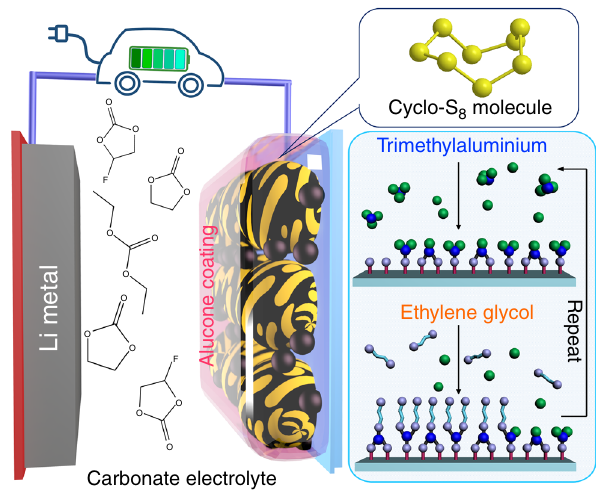
Fig. 1 Schematic of a lithium sulfur battery in carbonate-based electrolyte. Alucone coating is applied to carbon – sulfur electrodes and the sulfur cathode is in cyclo-S 8 molecule format. Alucone thin fi lm is directly deposited on the C – S electrodes by alternatively introducing trimethylaluminium and ethylene glycol via molecular layer deposition. Blue balls represent aluminium, green ball represent methyl, and gray balls represent